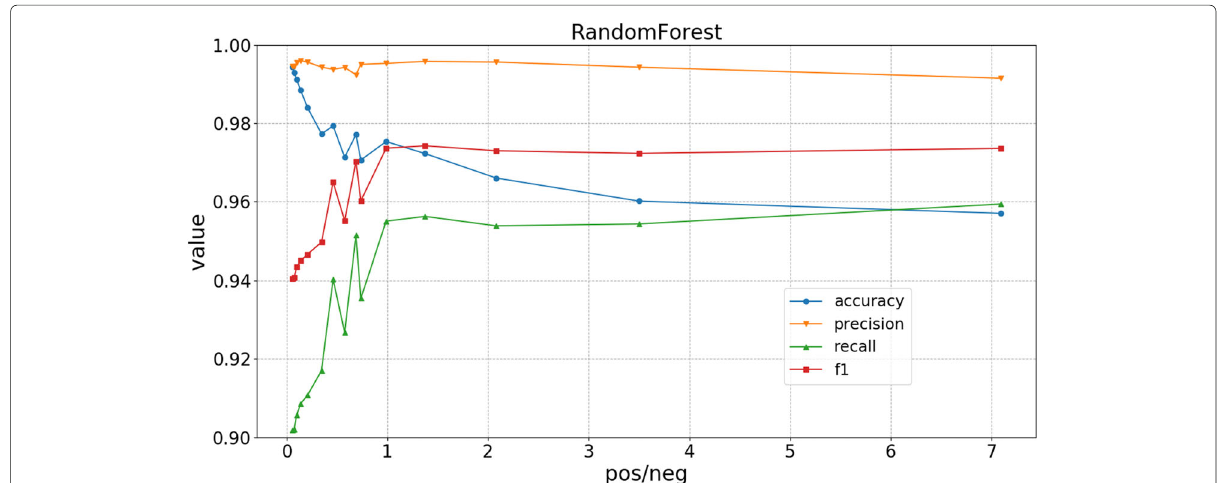
Fig. 10 Result of RF with different ratios of positive/negative samples. We tested the Random Forest classifiers using the following positive/negative ratios: 7.089, 3.499, 2.081, 1.375, 0.988, 0.727, 0.462, 0.346, 0.278, 0.139, 0.099, 0.075, and